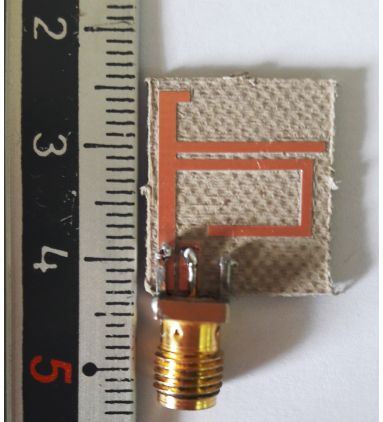
Figure 8: Fabricated tri-band antenna photograph